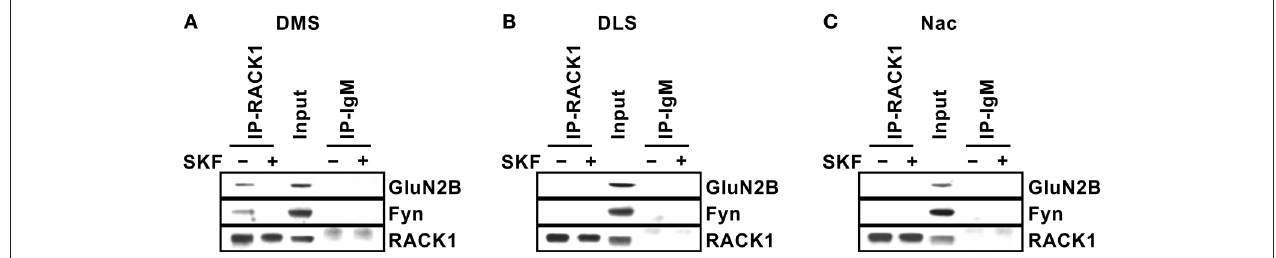
FIGURE 6 | Differential compartmentalization of Fyn and GluN2B in the DMS, DLS, and NAc. Striatal slices were treated with SKF81297 (SKF, 10 µ M) or vehicle (0.1% DMSO) for 15 min, followed by dissection of the DMS (A) , DLS (B) , and NAc (C) . The tissue was then lysed and RACK1 was IPed using anti-RACK1 antibodies (IP RACK1) and co-IP of Fyn and GluN2B was evaluated. Mouse IgM was used as a negative control (IP IgM) and protein levels in the total lysates were measured in parallel (Input). Immunoreactivity of RACK1 (lower panels), Fyn (middle panels) and GluN2B (upper panels) was detected by western blot analysis. n =